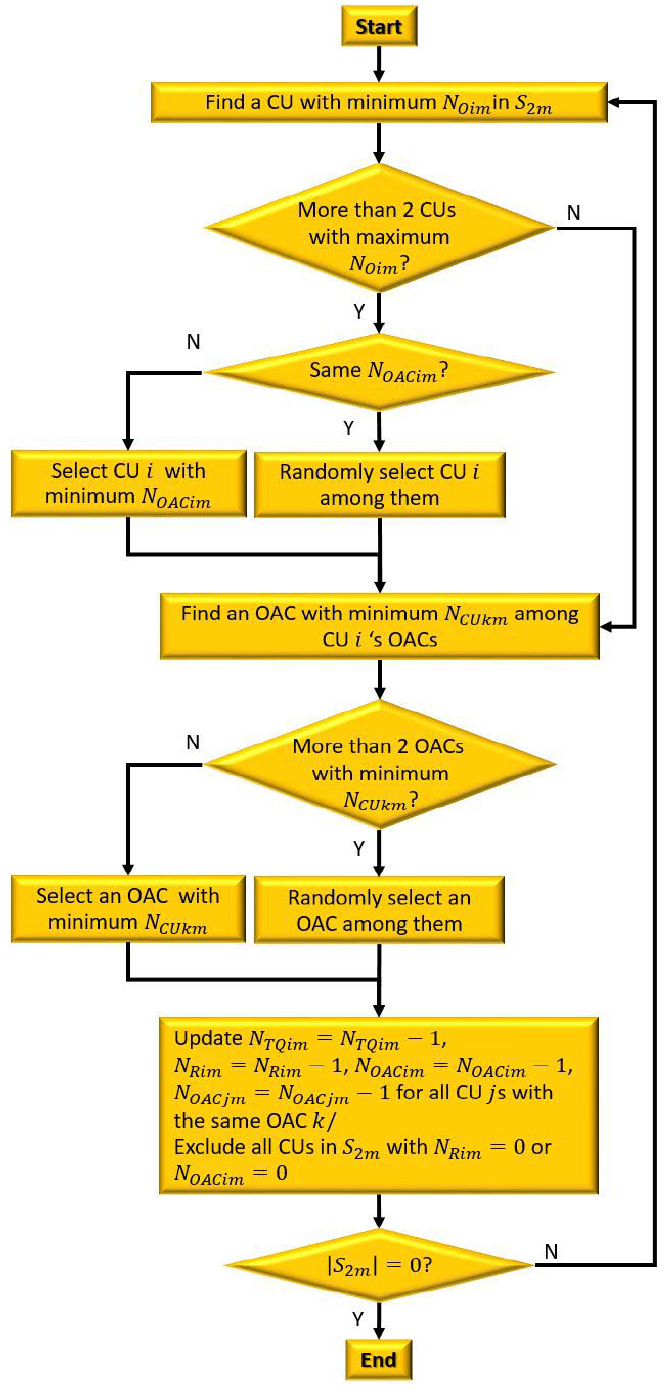
Figure 8. A flow chart of OAC allocation.